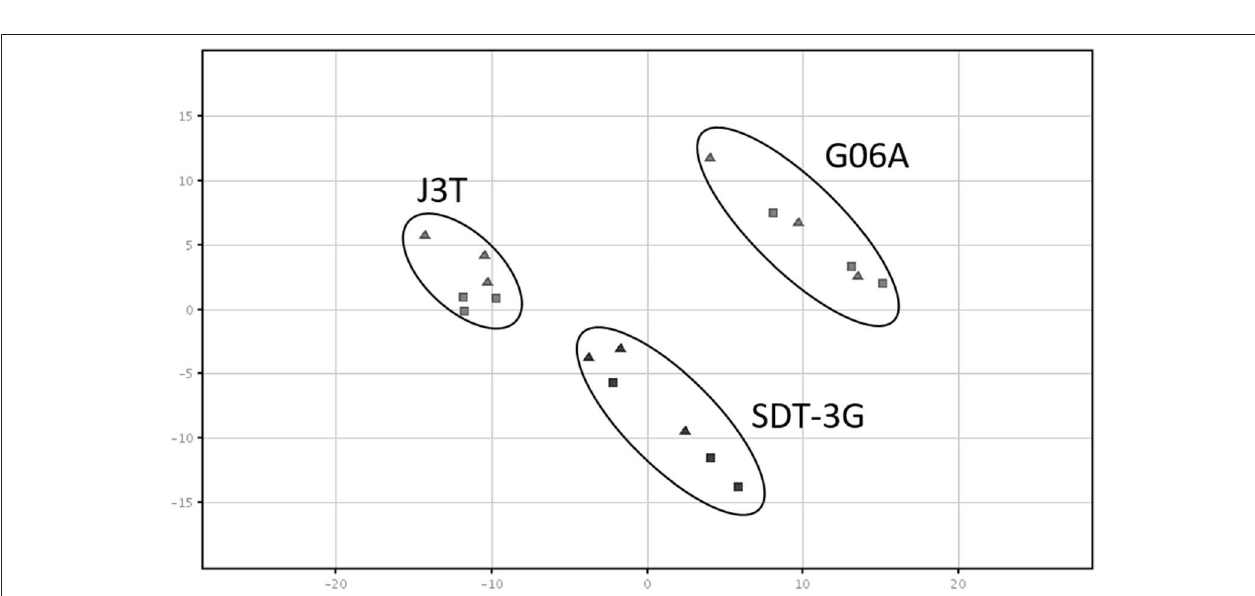
FIGURE 2 | Principal component analysis plot of samples. All sample types cluster separately, with a closer relationship of cell line samples (normoxia and hypoxia) with each other. The triangles indicate normoxic samples, while squares indicate hypoxic samples.